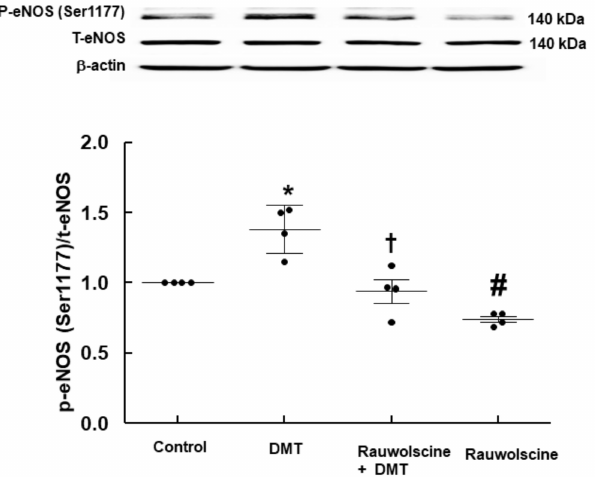
Figure 7. Effect of rauwolscine on dexmedetomidine (DMT)-induced endothelial nitric oxide synthase (eNOS, Ser1177) phosphorylation in human umbilical vein endothelial cells (HUVECs). HUVECs were treated with DMT (10 − 6 M) alone for 5 min and with rauwolscine (10 − 6 M) for 1 h, followed by treatment with DMT (10 − 6 M) for 5 min or rauwolscine (10 − 6 M) alone for 65 min. Data ( n = 3) are shown as mean ± standard deviation. n indicates the number of independent experiments. * p < 0.01 and # p < 0.05 versus control. † p < 0.001 versus DMT alone. P-eNOS, phosphorylated eNOS; T-eNOS, total